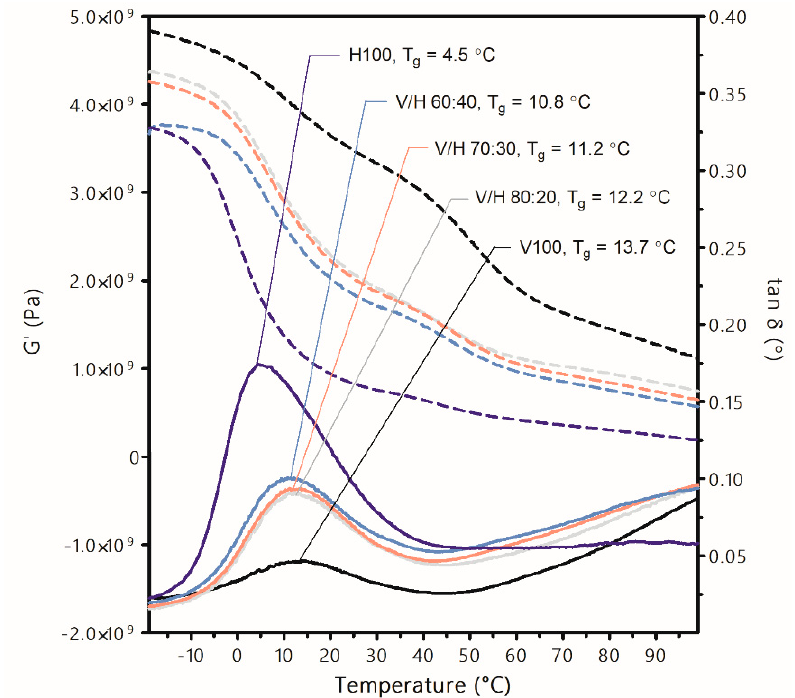
Figure 8. Storage modulus (G’, left axis, discontinuous lines) and tan δ values (right axis, continuous lines) of poly(3-hydroxybutyrate- co -3-valerate) (PHBV), poly(3-hydroxybutyrate- co -3-hydroxyhexanoate) (PHBH), and their blends. Glass transition temperatures (T g ) are also